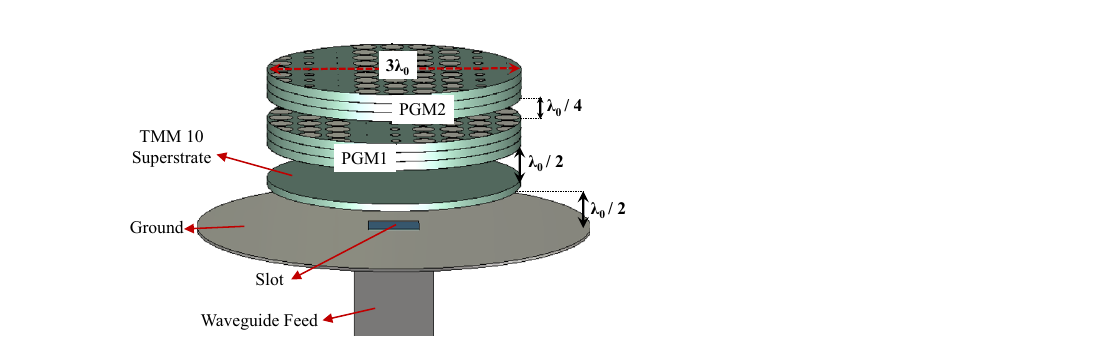
Figure 10. Compact NFMS system